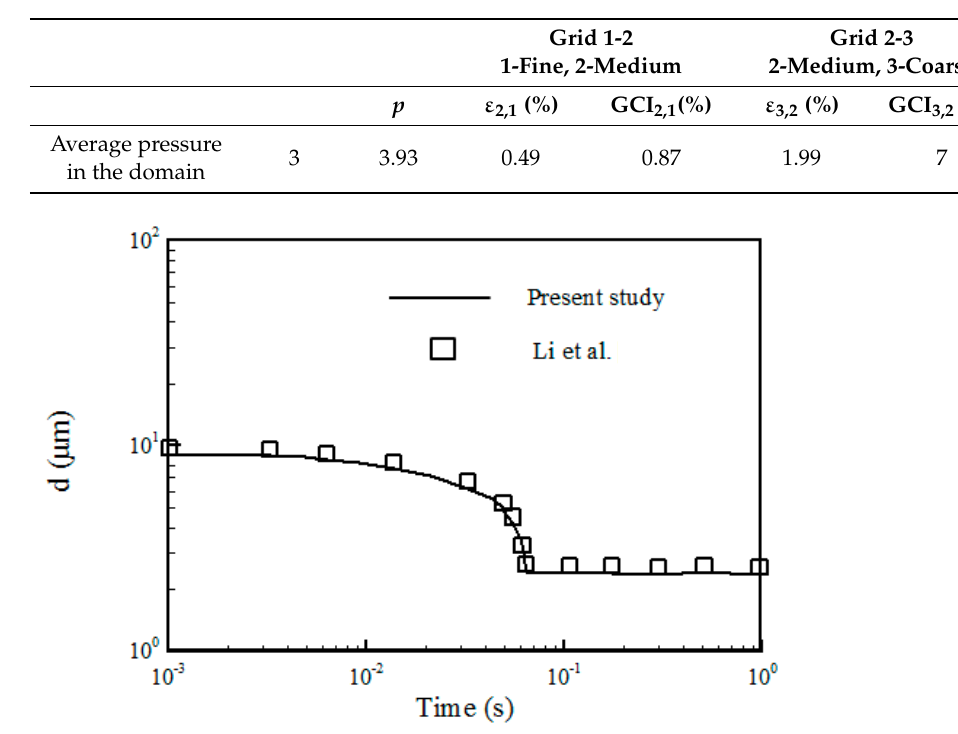
Figure 5. Validation of the present computational results for an evaporating 10 μ m droplet by comparison with the data from [3].